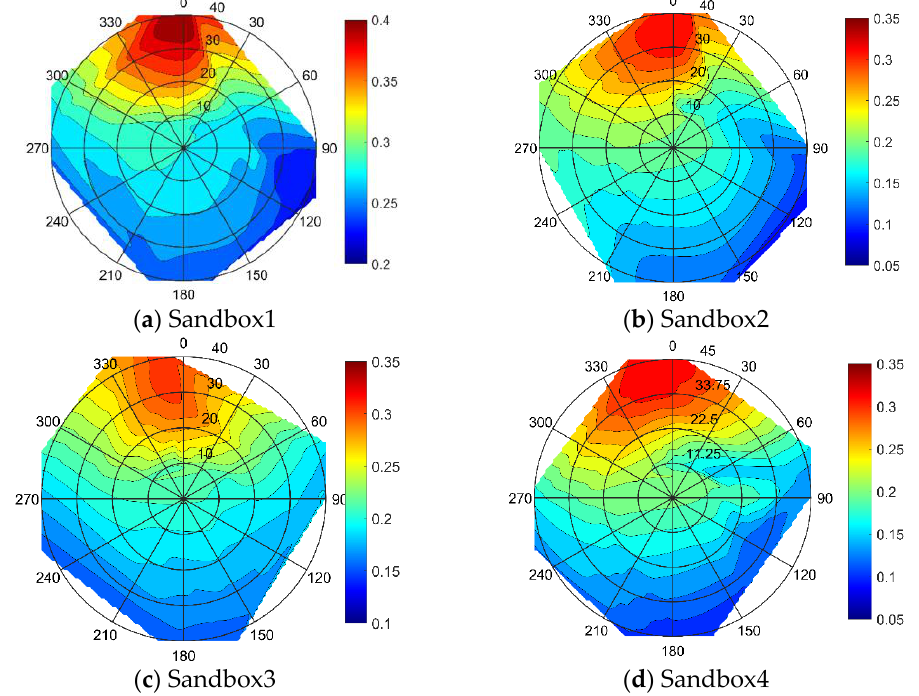
Figure 4. Hemispheric distributions of the NIR reflectance observed for the four sandboxes. In polar plots, the radii orient with the relative azimuth angles and the concentric circles corresponding to the view zenith angles.